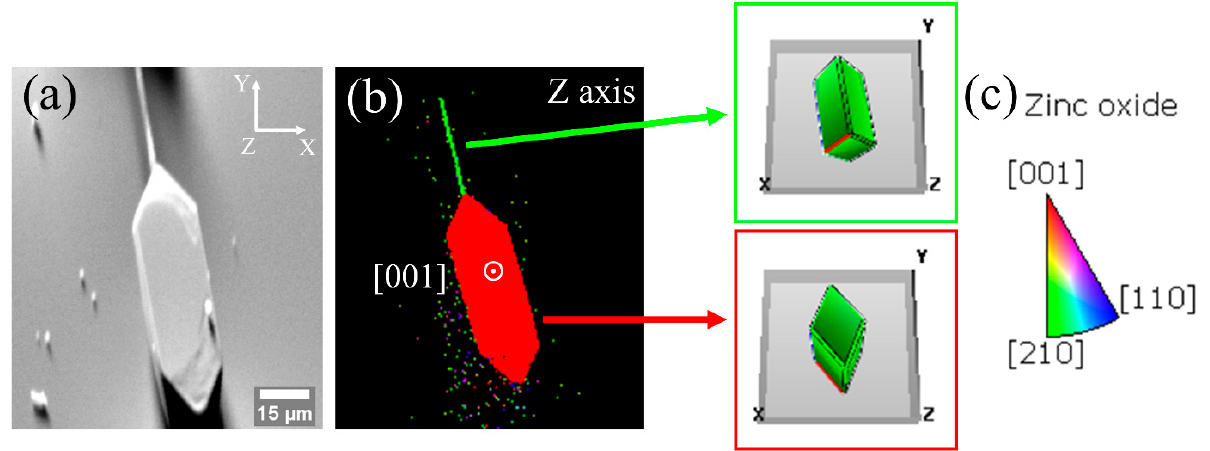
Figure 8. EBSD analysis. ( a ) Image of secondary electrons where the directions of the detector axes are fixed in the upper right corner. ( b ) EBSD map taken along Z axis. ( c ) Legend of the color scale used in EBSD maps. The colors indicate the proximity to the crystallographic directions indicated in ( b ).